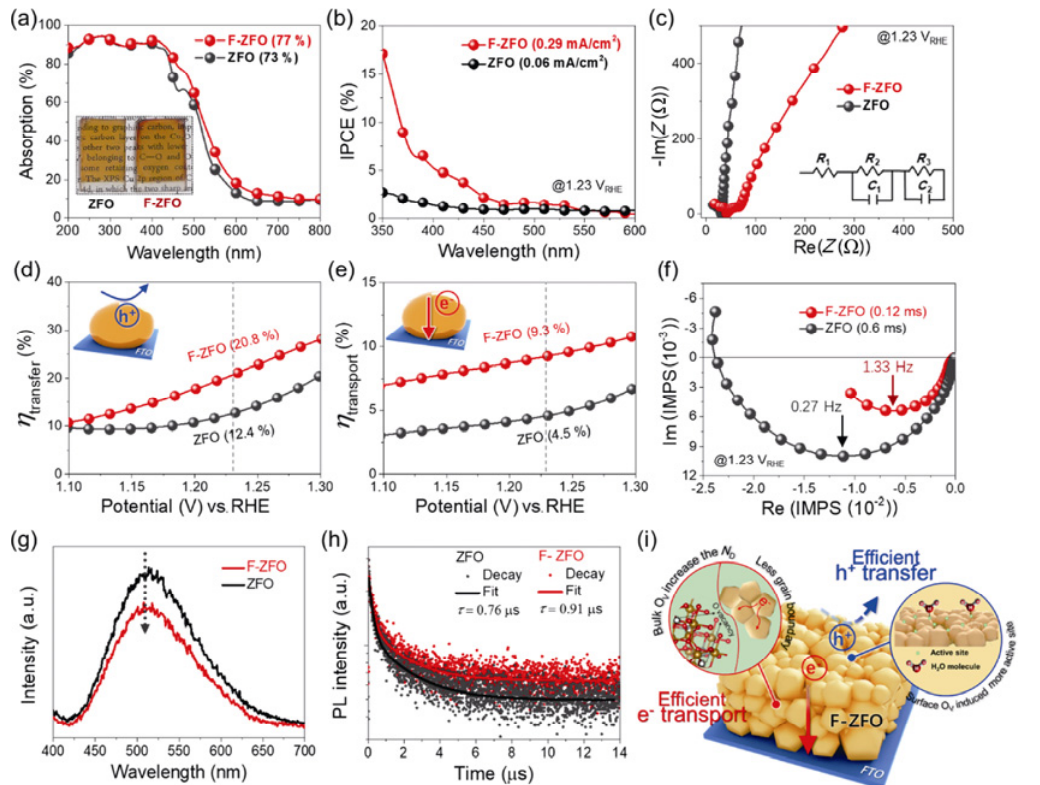
Fig. 4 Optical property, spectral response, charge transport, and transfer kinetics analyses. (a) Light absorption spectra. The inset image shows a photograph of ZFO and F-ZFO samples. (b) Incident photon to current conversion efficiency (IPEC) spectra. (c) Nyquist plot. (d) Charge transfer efficiency ( η transfer ) and (e) charge transport efficiency ( η transport ). (f) Intensity-modulated photocurrent spectroscopy (IMPS) spectra. (g) Photoluminescence (PL) spectra and (h) time-resolved photoluminescence (TRPL) spectra of ZFO and F-ZFO under an excitation of 374 nm. (i) Impacts of flame activation on the improvement of the